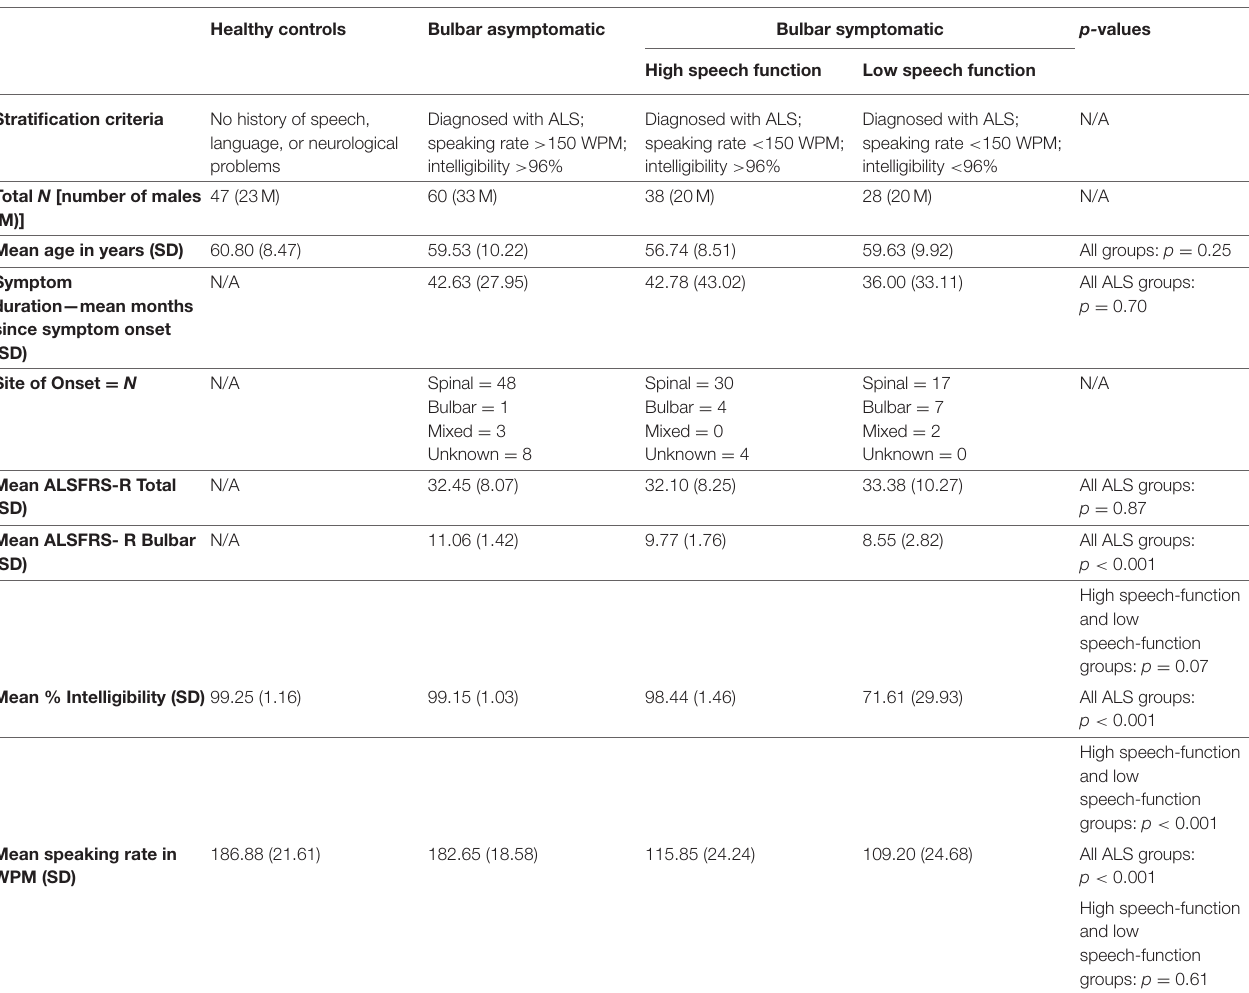
TABLE 2 | Demographic information of participants. Healthy controls Bulbar asymptomatic Bulbar symptomatic p-